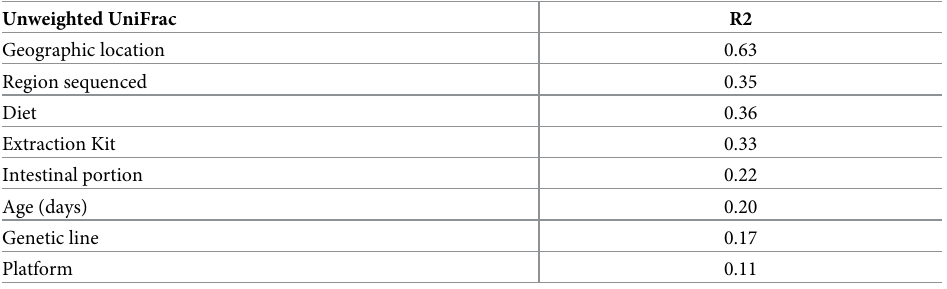
Table 2. Calculated fit of metadata factors to unweighted UniFrac community distances for chicken microbiota using ADONIS. Unweighted UniFrac R2 Geographic location 0.63 Region sequenced 0.35 Diet 0.36 Extraction Kit 0.33 Intestinal portion 0.22 Age (days) 0.20 Genetic line 0.17 Platform 0.11 Statistical significance identified for all factor ( P <